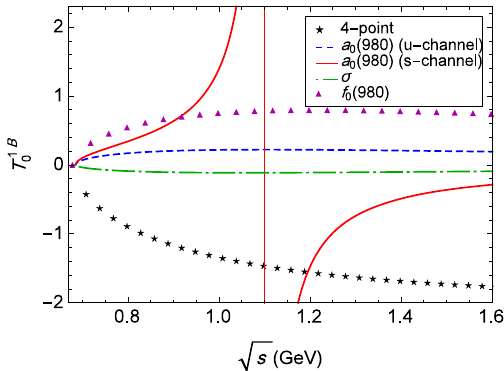
Fig. 2 Prediction of the single nonet linear sigma model (SNLSM) for . The zero of this function (square) is at the location the real part of T 1 0 of “bare” isovector scalar mass